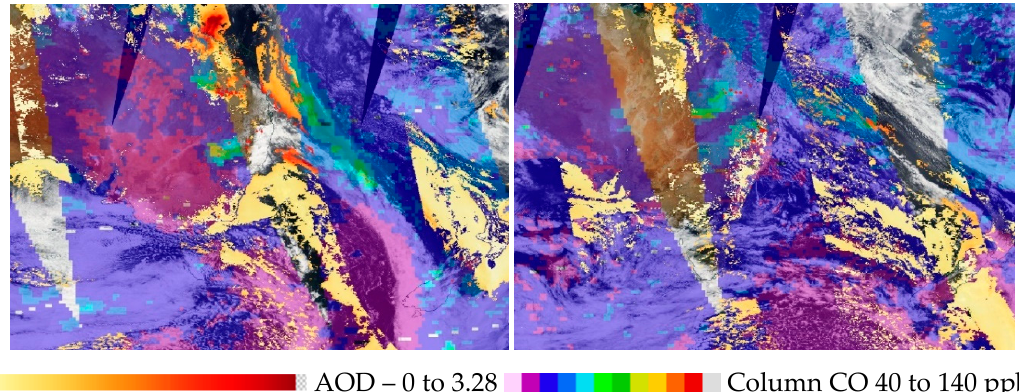
Figure 15. AOD ( yellow and red ) and CO column concentration Aqua / Airs ( pink and green ) over the Tasman sea, as revealed by MODIS on 14 February 2019 ( left ) and 15 February 2019 ( right ).